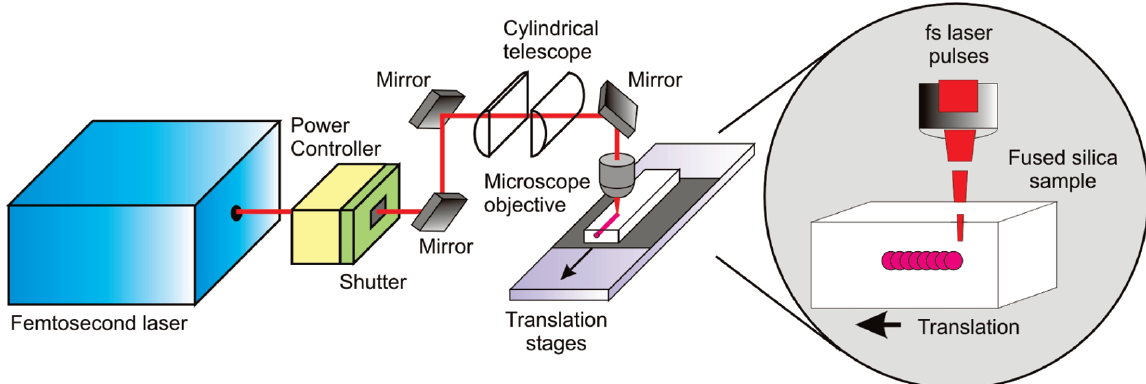
Figure 1. Setup used for femtosecond laser